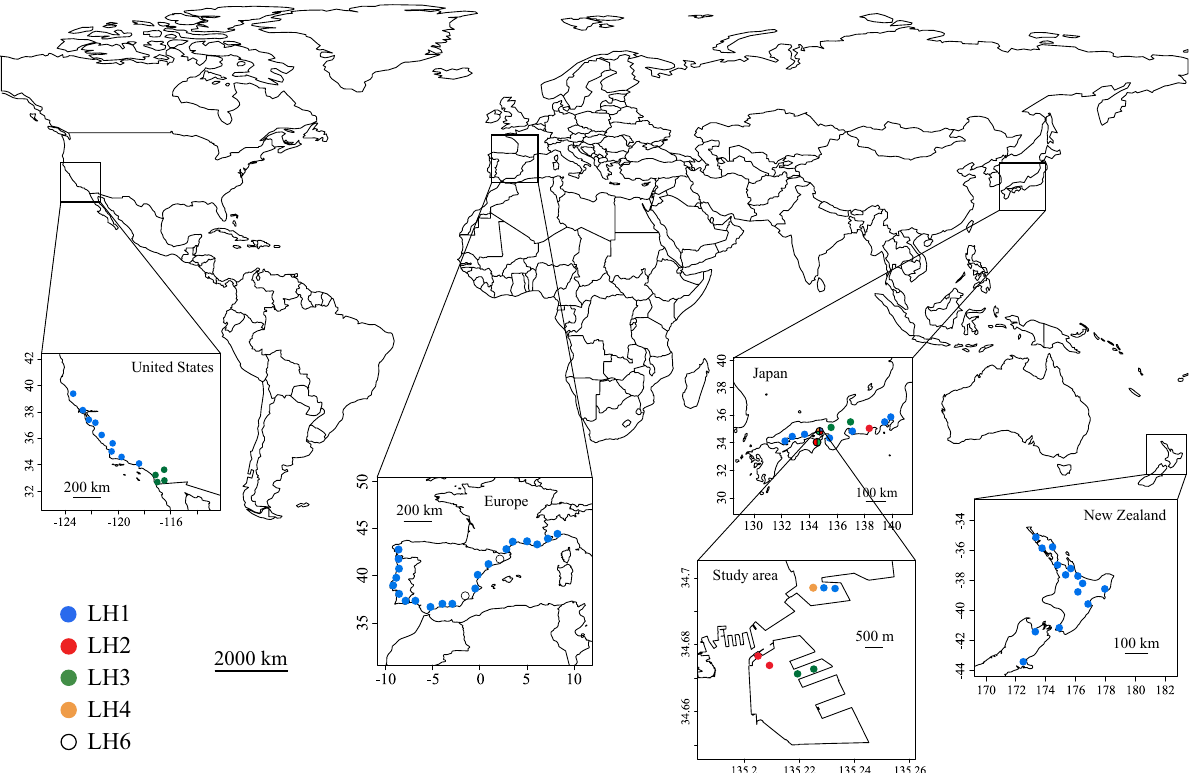
Figure 1. Distribution of Argentine ant ( Linepithema humile ) supercolonies of different haplotypes in each introduced region (partially modified by Tsutsui et al. 22 ; Giraud et al. 16 ; Corin et al. 23 ; Inoue et al. 18 ) and the locations of the sampling sites in this study. The name of each supercolony follows Inoue et al. 18 . The world map was plotted by R 25 using 1: 50 m million scale vector data (ver. 4.0.0) provided by Natural Earth (https